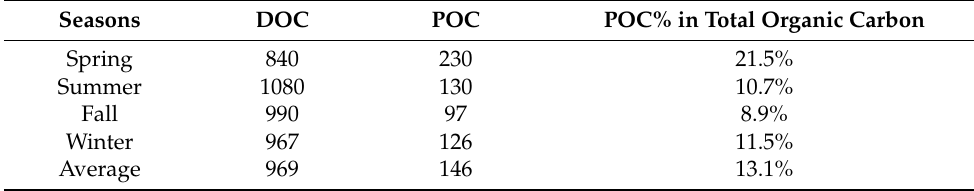
Table 4. Seasonal POC and DOC average integral measured data (Unit: mg m − 3 ). Seasons DOC POC POC% in Total Organic Carbon Spring